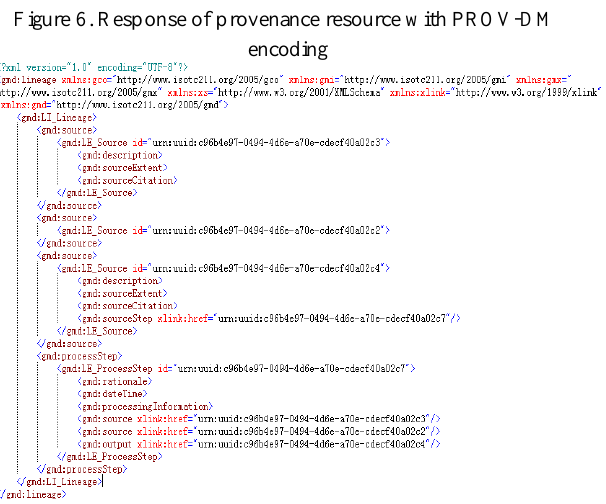
Figure 6. Response of provenance resource with PROV-DM